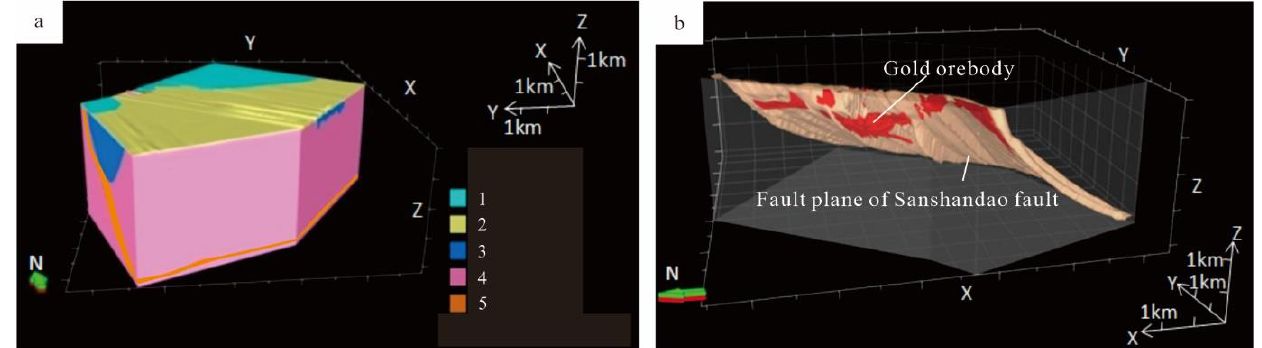
Figure 2. 3D geological model of the Sanshandao supergiant gold deposit ( a ) and superposition map of fault plane on gold orebodies ( b ). 1 — Sea area; 2 — Quaternary; 3 — Early Precambrian metamor- phic rock series; 4 — Linglong-type granite; 5 — Alteration zone of Sanshandao fault. rock series; 4—Linglong-type granite; 5—Alteration zone of Sanshandao